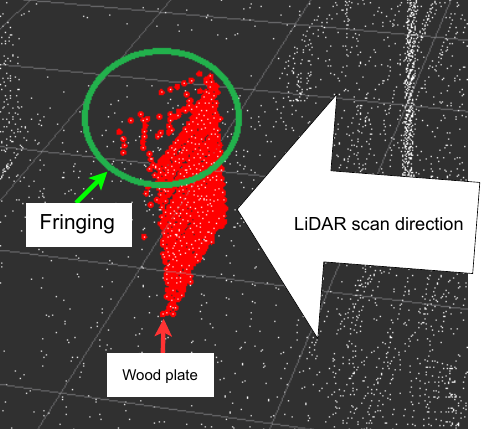
Figure 8. The red point cloud contains the reflections of the reference plane. The fringing at the top is noticeable (marked in the green circle), which is also known as edge